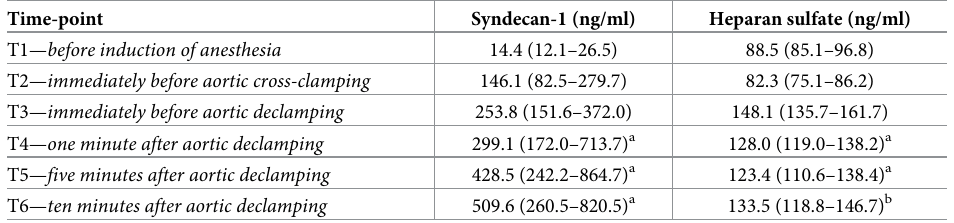
Table 2. Concentrations of syndecan-1 and heparan sulfate in systemic arterial